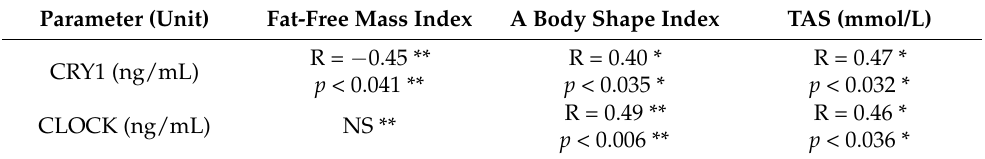
Table 2. Indices of correlation and levels of statistical significance in cases of analyses the relationship between CRY1, CLOCK, and selected anthropometric parameters in HT. Parameter (Unit) Fat-Free Mass